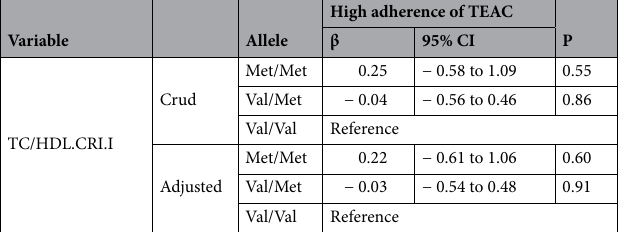
Table 6. The interaction of BDNF Val/Met polymorphism and TEAC on anthropometric indices, lipid profile and atherogenic indices. Val/Val genotype is considered as a reference. Low adherence of DTAC is considered as a reference. Generalized linear model; crude model and adjusted model Age, physical activity, sex, smoking, alcohol, energy intake, lipid, and glucose-lowering medicines, and family history of diabetes, as covariates. Bold values denote statistical signifcance at the P < 0.05 level. TEAC trolox equivalent antioxidant capacity, CI confidence interval, AIP (Atherogenic index of plasma): log(TG/HDL), AC (Atherogenic coefficient): (TC-HDL/HDL), CRI-II (Castelli s risk index): LDL/HDL, CRI-I (Castelli s risk index): TC/HDL, TC total cholesterol, TG triglyceride, HDL high density lipoprotein, LDL low density lipoprotein, WC waist